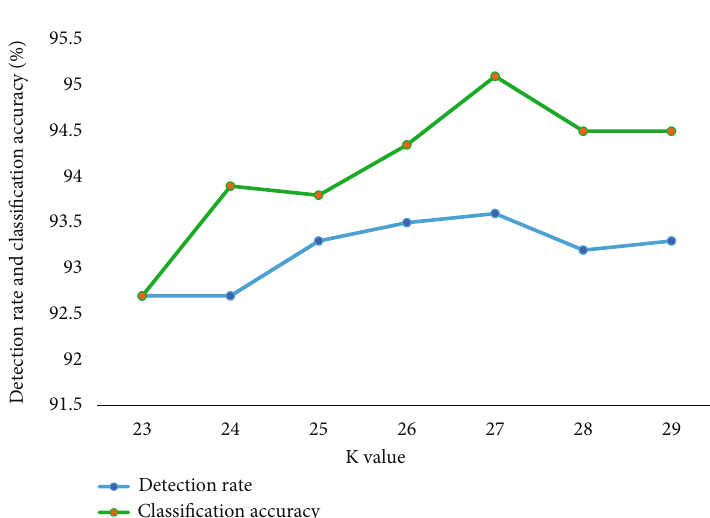
Figure 4: Graph of IXB- K of the training set.